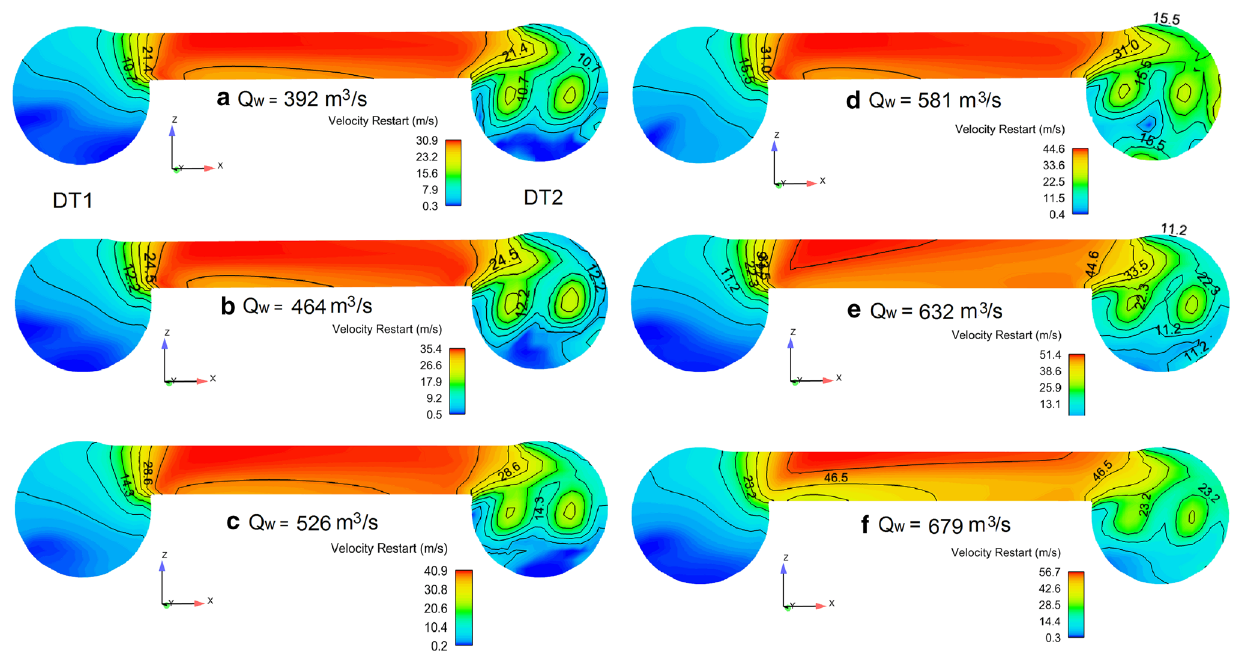
Fig. 12 Velocity contours of enhanced design no